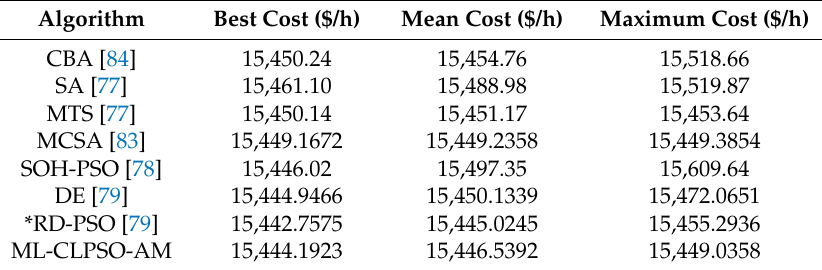
Table 8. Comparison test results on a 6-unit system.